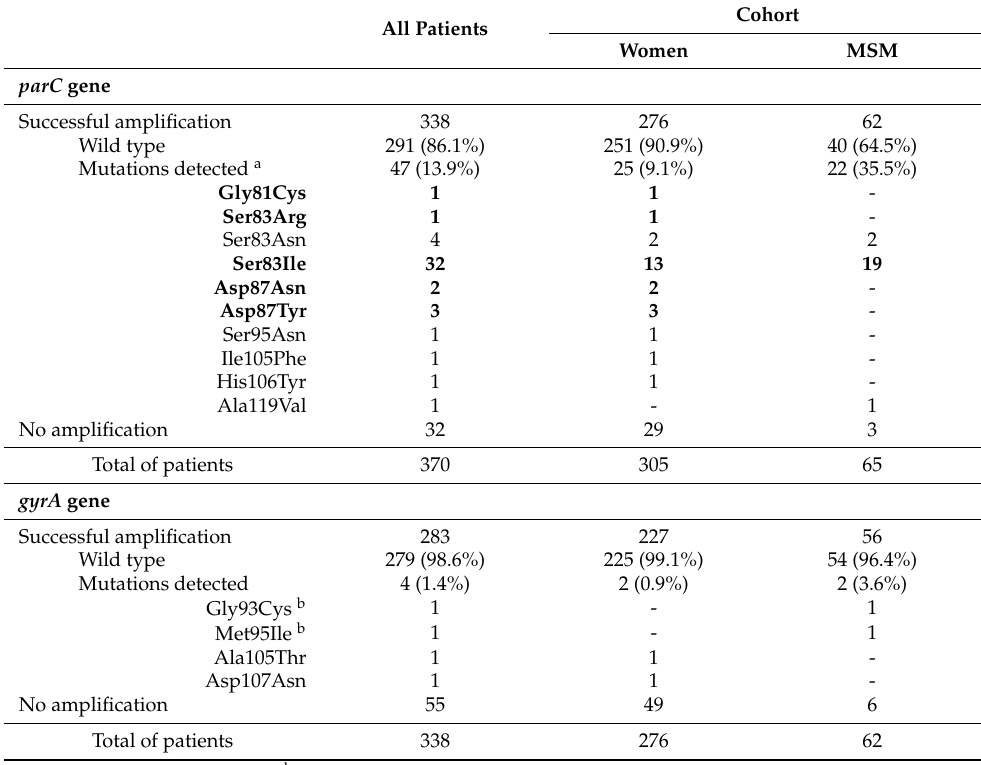
Table 2. Fluoroquinolone resistance-associated mutations in M. genitalium -positive patients. All